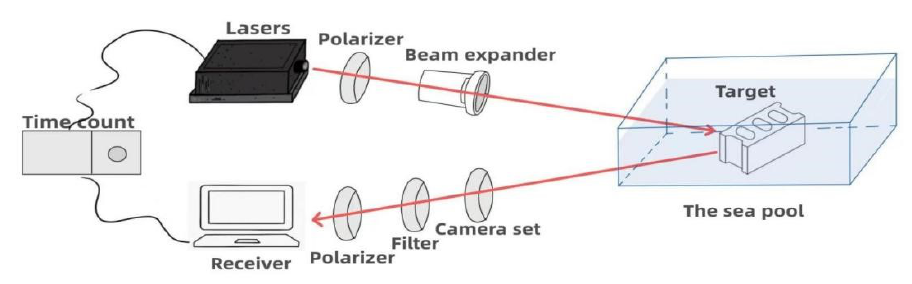
Figure 5. Experimental setup for measuring polarization characteristics under water.